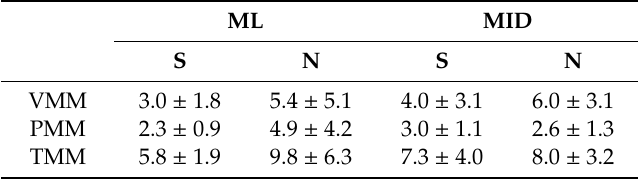
Table 1. Summary of heterotrophic prokaryote mortality rates. Data for total microbial-mediated mortality (TMM), viral-mediated mortality (VMM) and protist-mediated mortality (PMM) are presented as averages ( × 10 8 cells L − 1 d − 1 ) ± standard deviation for the mixed layer (ML; 15 m) and mid sampling depths (MID; 25–85 m) of the southern (S; 30–45 ◦ N) and northern (N; 46–63 ◦ N) regions of the meridional transect. ML MID S N S